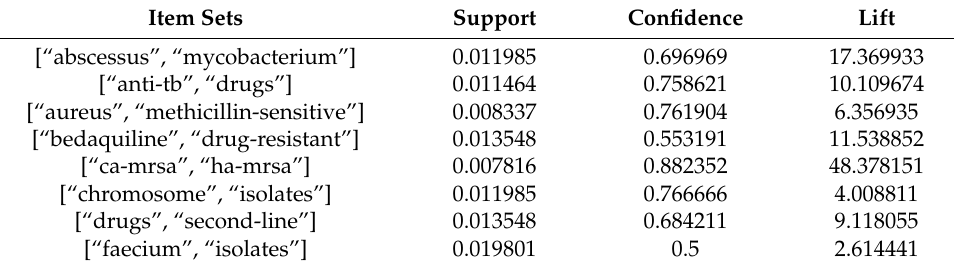
Table 6. Sample item sets of linezolid dataset.